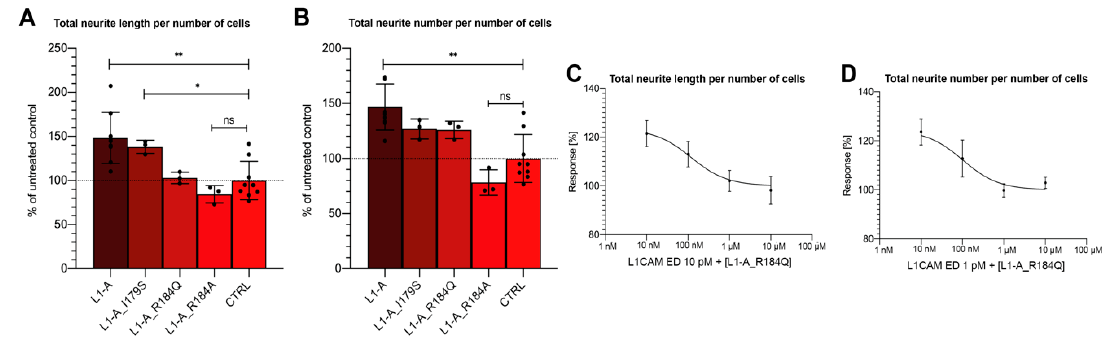
Figure 2. Effect of CRASH-derived peptides on proliferating SH-SY5Y cells. ( A ) Total neurite length per number of cells, ( B ) neurites per number of cells. Treatment with mutant peptides hampers neurite elongation, whereas has a limited effect on sprouting. ( C ) Total neurite length per number of cells treated with 10pM L1CAM ED and increasing concentration of L1-A_R184Q (from 10nM to 10 µM). ( D ) Total neurite length per number of cells treated with 1pM L1CAM ED and increasing concentration of L1-A_R184Q (from 10 nM to 10 µM). All data represent the mean ± SD of at least three independent experiments. Significance at p ≥ 0.05 (ns), p < 0.05 (*), p < 0.001 (**), between treated samples and untreated control is reported.